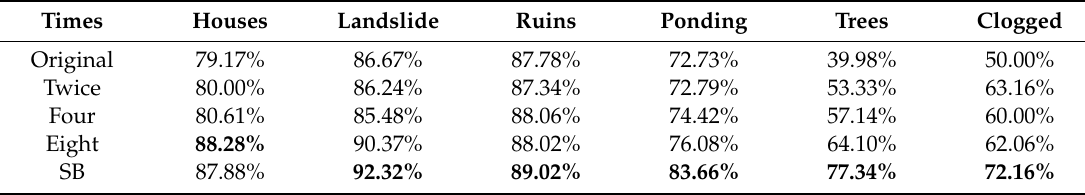
Table 11. F1 score results after each data augmentation of the PEMSR model. SB refers to the F1 score results after data balancing. The bold values are the best results for each